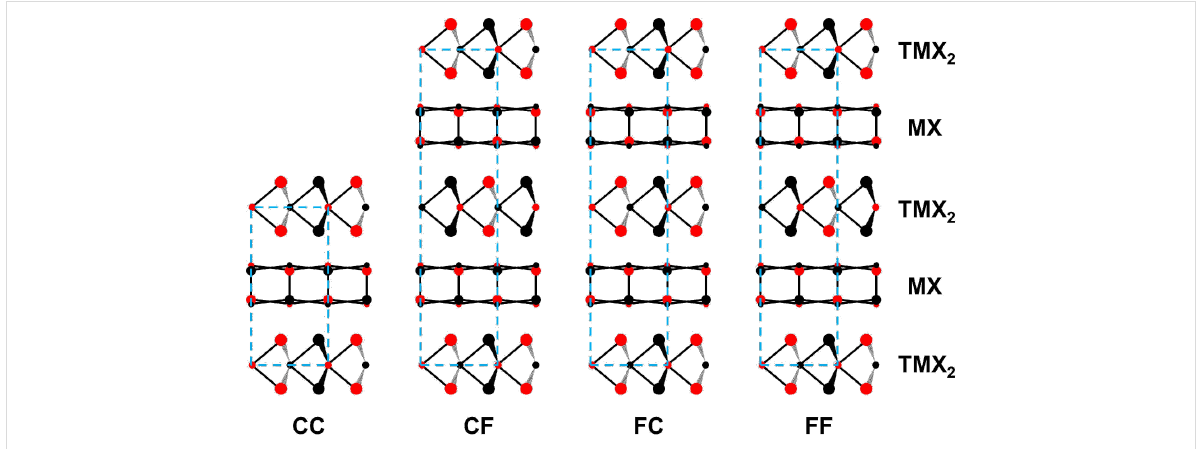
Figure 4: Different possible stacking types of misfit compounds projected along the [100] direction. The blue boxes denote the unit cell and the colored circles represent the metal (small circles) and chalcogenide atoms (large circles), where the different colors represent the different positions in space: black atoms above the paper-plane and red ones beneath it. Adapted with permission from [3]. Copyright 1995